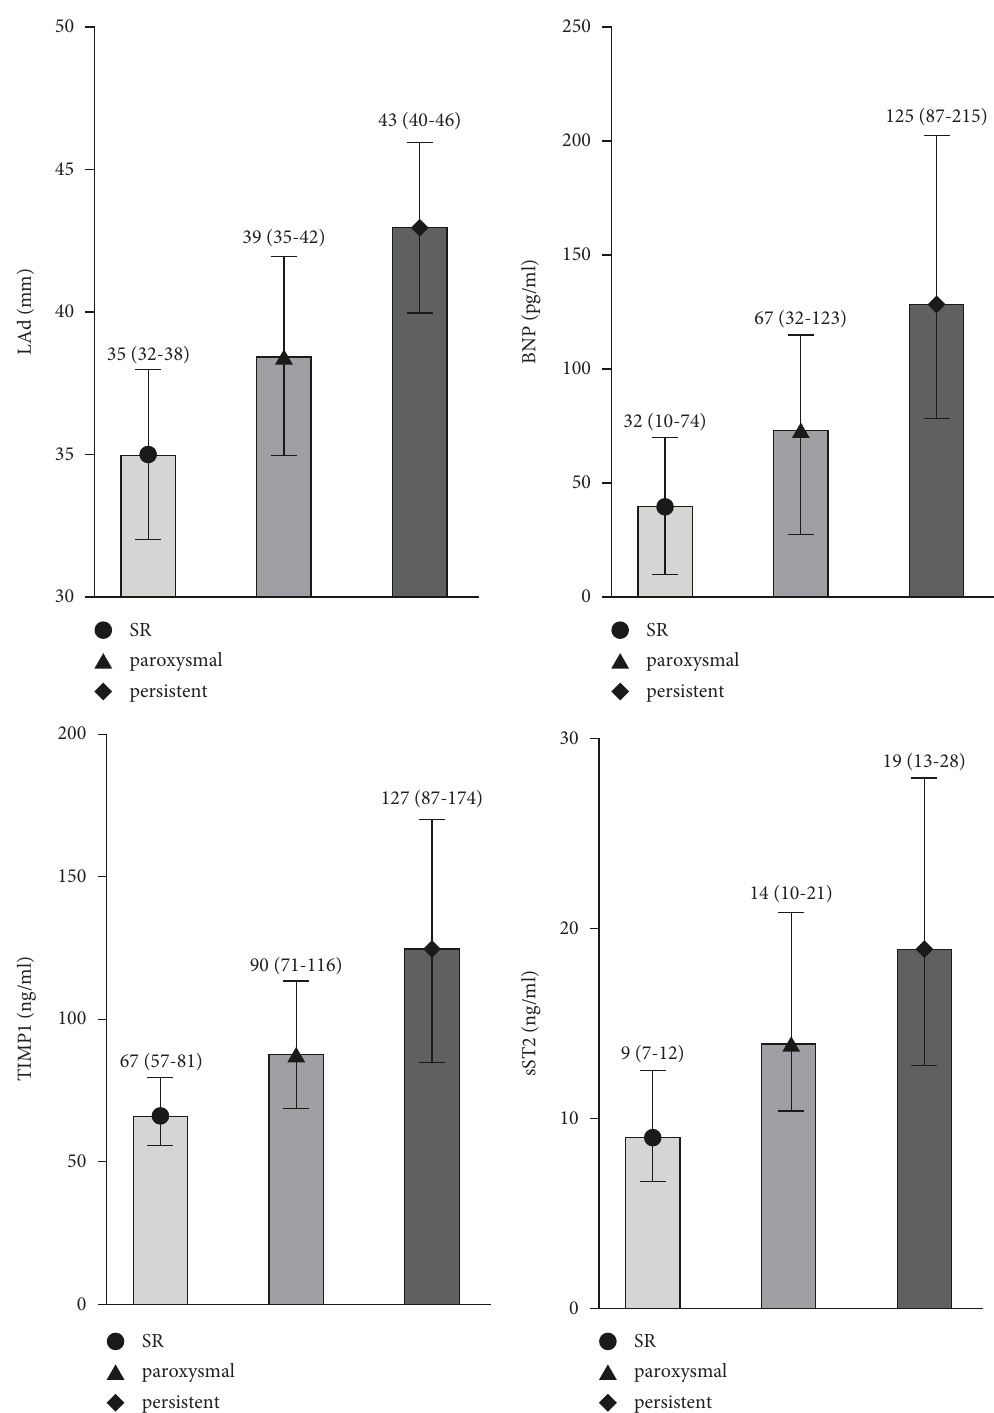
Figure 2: Soluble suppression of tumorigenicity 2 protein, tissue inhibitor of matrix metalloproteinase, and brain natriuretic peptide levels and the left atrial